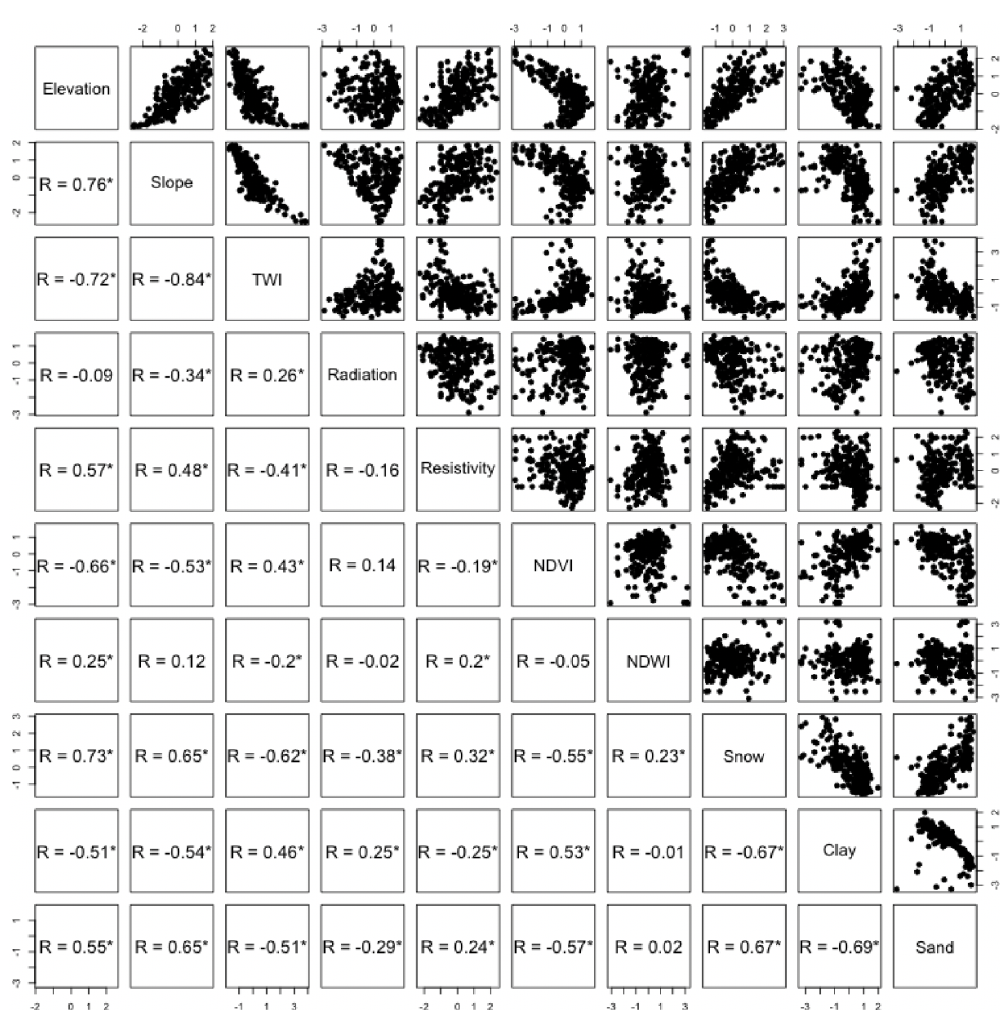
Figure 3. Correlation and scatter plots (Pearson’s correlation coefficients) among selected hillslope features (Table S1). The * sign represents p values < 0 . 01.